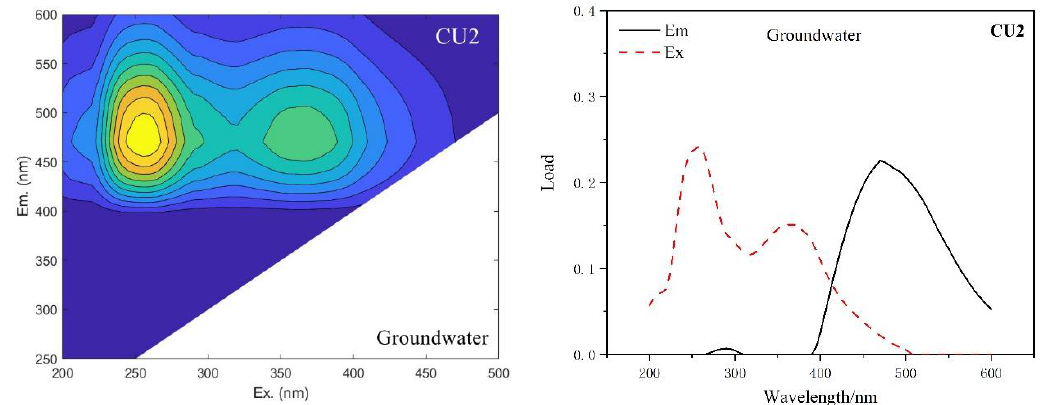
Figure 8. Three-dimensional spectral-fluorescence characteristics of different waters.